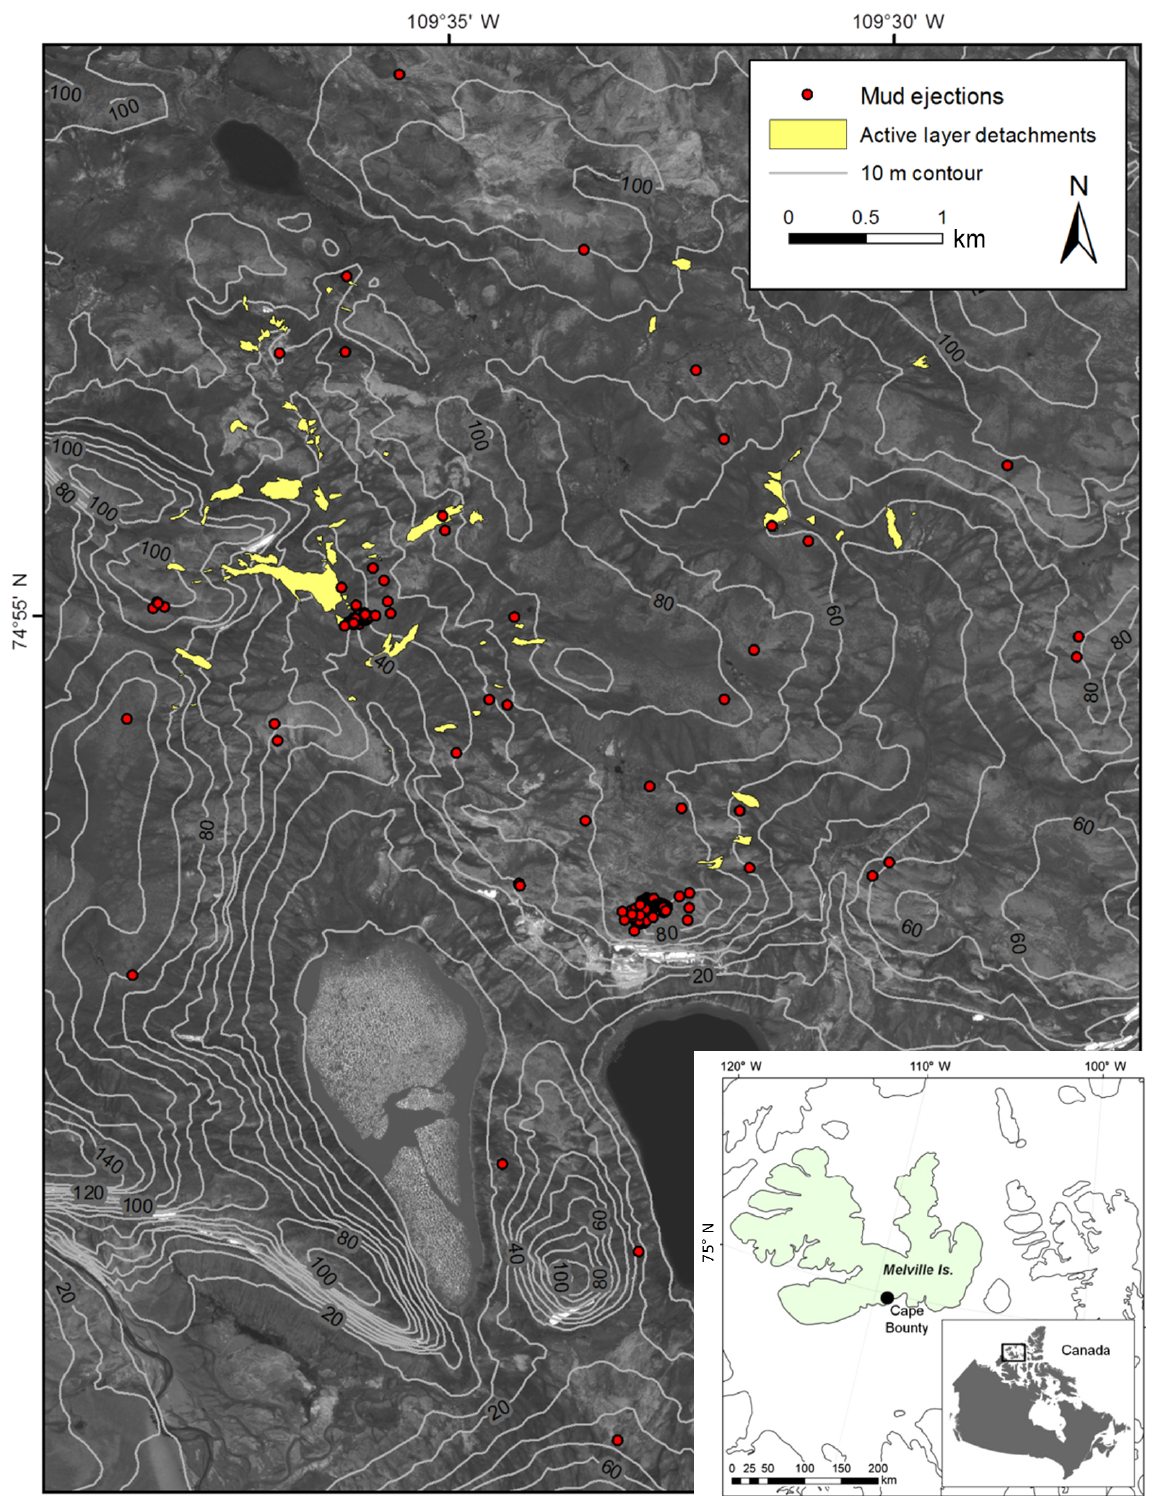
Figure 2. Map of the study area showing locations of ALDs (Rudy et al., 2013) and MEs (Holloway et al., 2016) at CBAWO. The contour interval is 10m and was derived from a 1m digital elevation model (DEM) obtained from stereo GEOEYE imagery acquired in 2012 (Collingwood, 2014). The inset map indicates the site location in the Canadian High